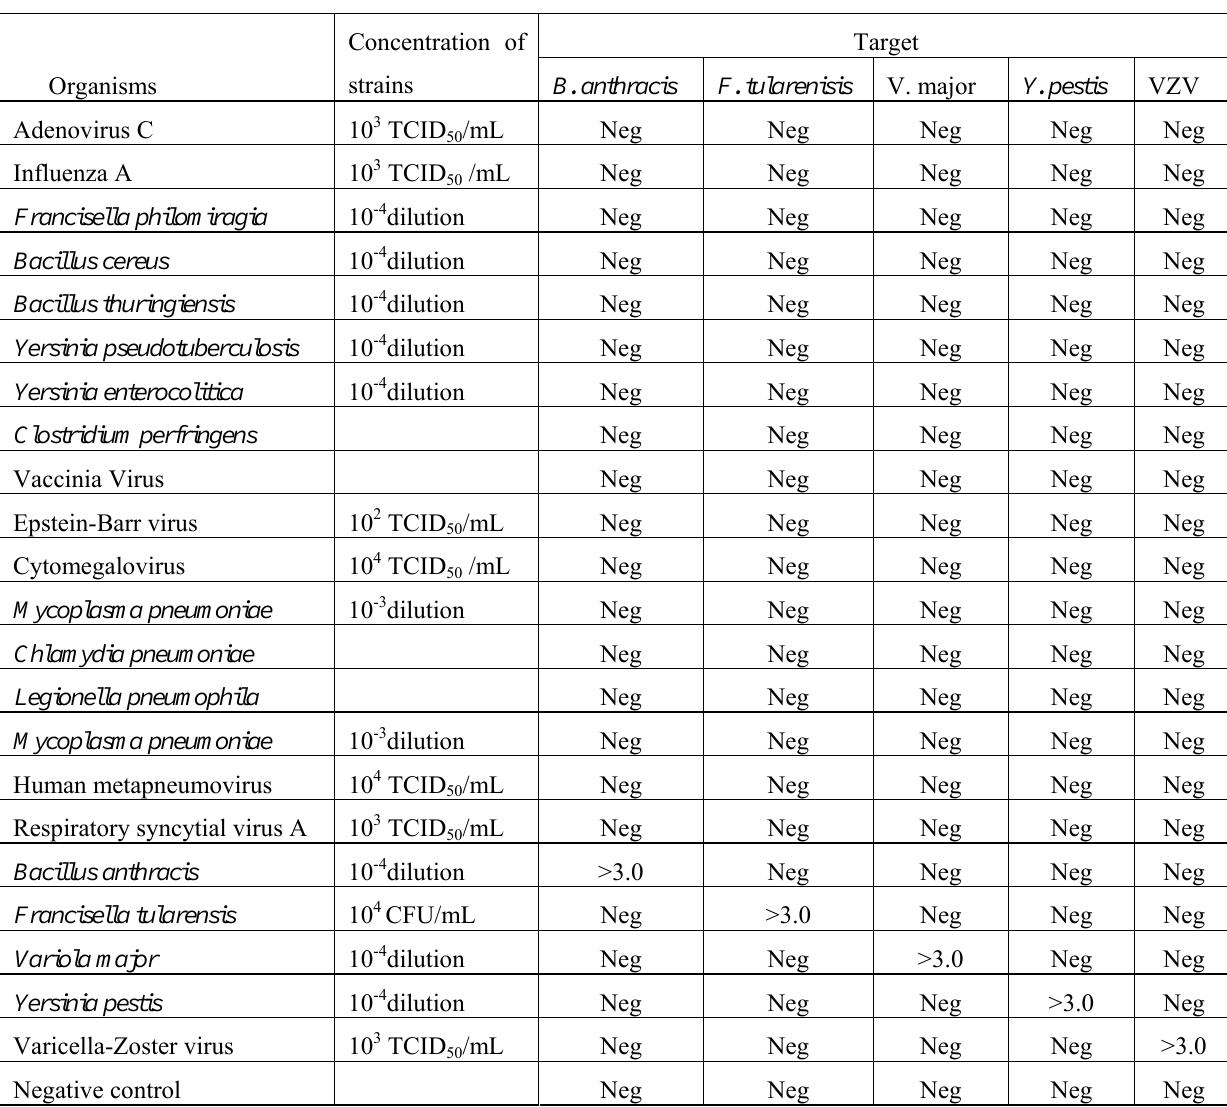
Table 3. Specificity of the BioT DNA and BioT RNA assays was tested against different